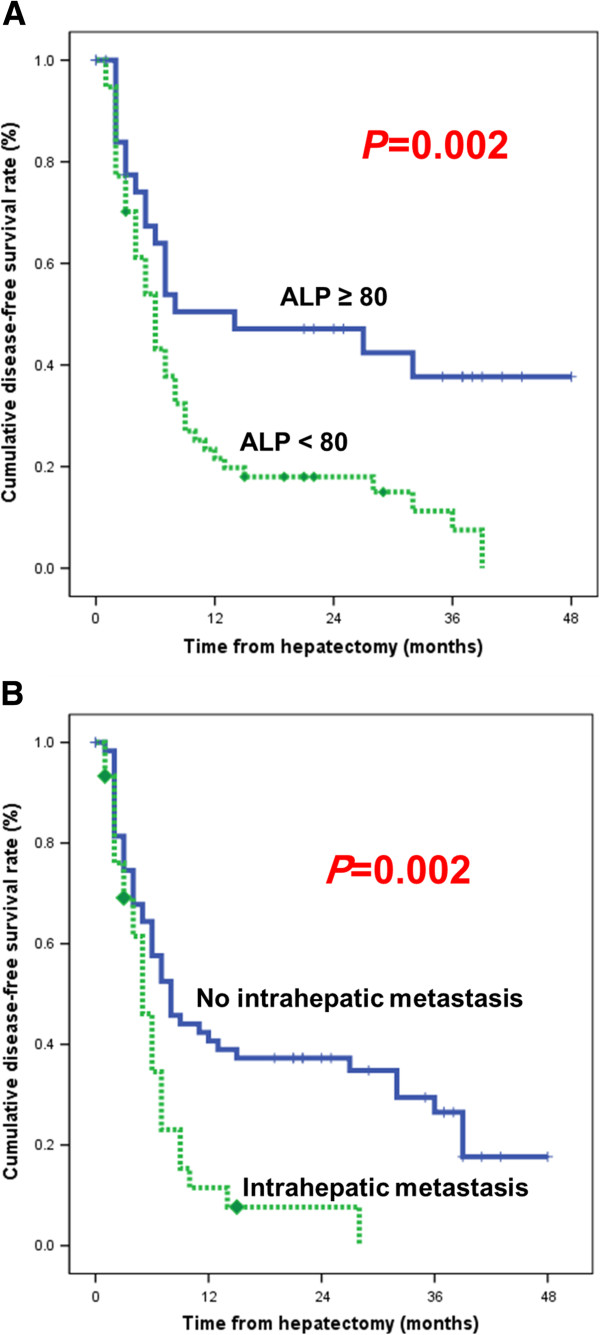
(A) Influence of ALP levels and (B) intrahepatic metastasis on disease-free survival.